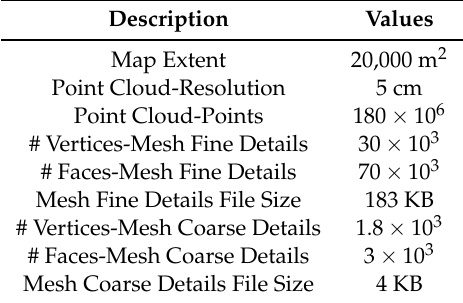
Table 2. Summary of point cloud vs. mesh storage